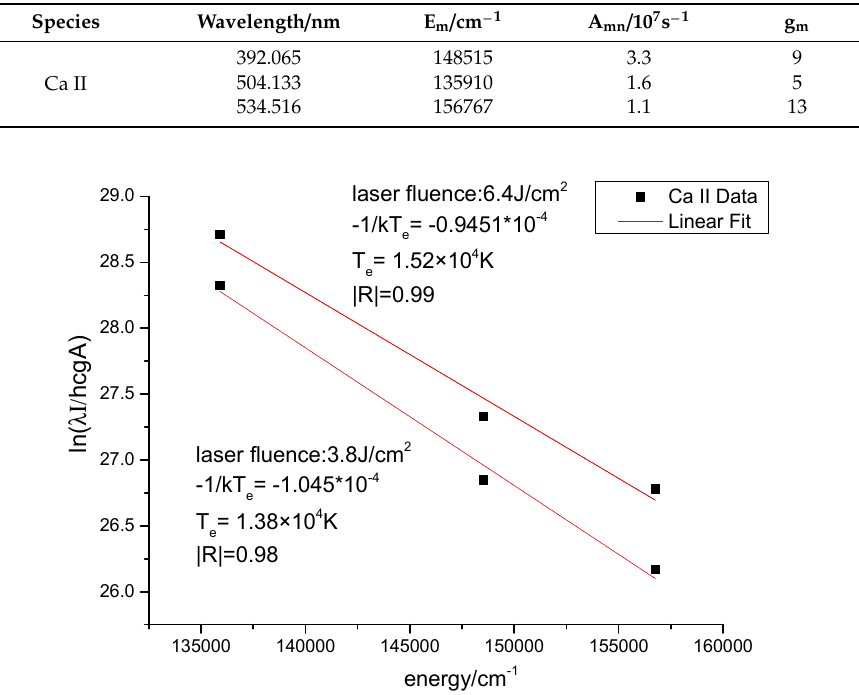
Figure 7. Boltzmann diagram of plasma electron temperature (obtained by 3 calcium atomic lines).